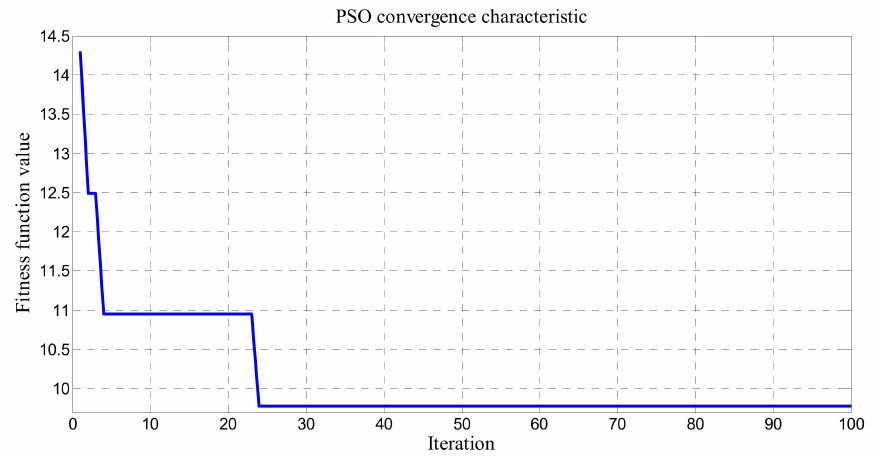
Figure 13. PSO convergence characteristic.